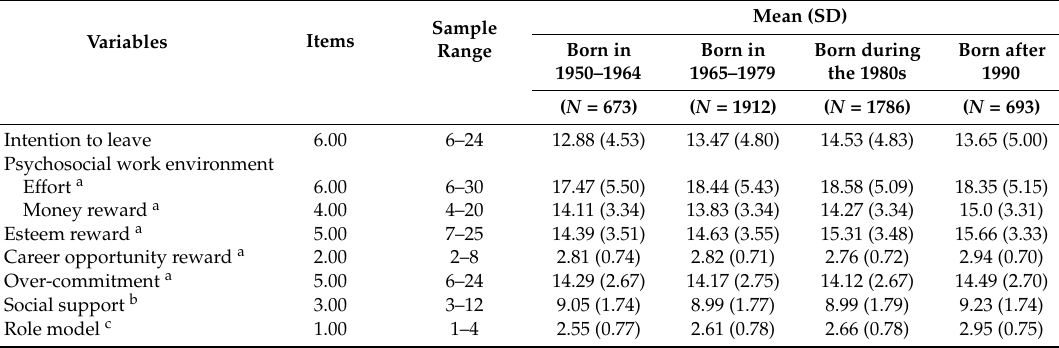
Table 2. Descriptive statistics for dependent variable and independent variables.